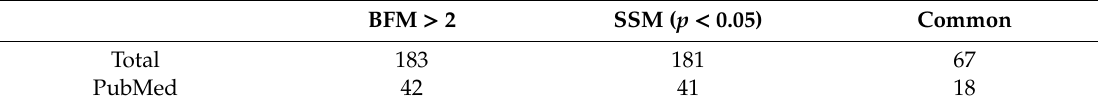
Table 4. Comparison of BFM and SSM for window size of 10 ( p < 0.05). BFM > 2 SSM ( p <